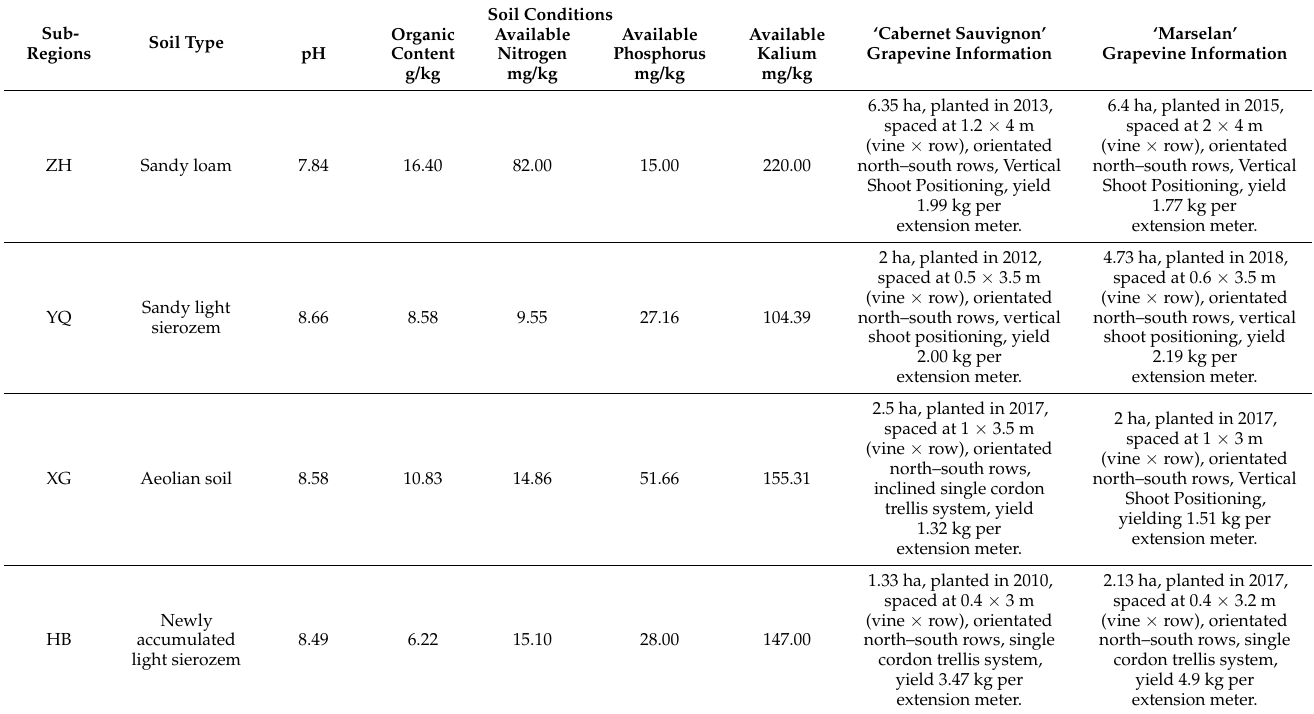
Table 1. Soil type and their physical–chemical parameters of sub-regions and description of